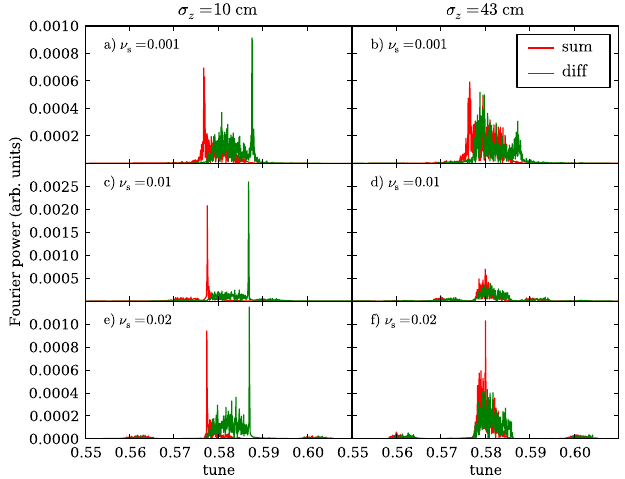
FIG. 12. (Color) Simulated one-on-one bunch y plane (cid:6) and (cid:1) mode tune spectra for short bunches [(a), (c), (e)] and long bunches [(b), (d), (f)] for three different synchrotron tunes, with a Tevatron-like lattice.